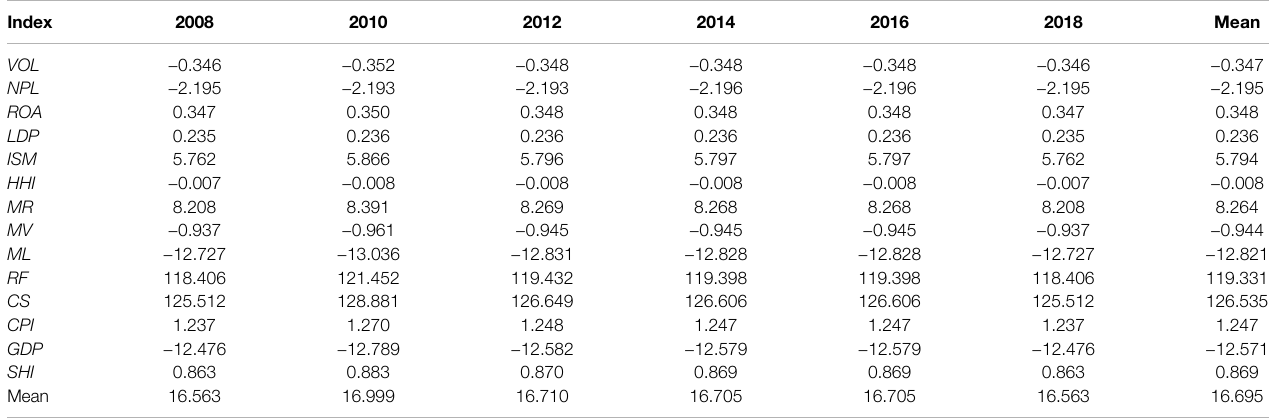
TABLE 10 | Total effects of risk factors.